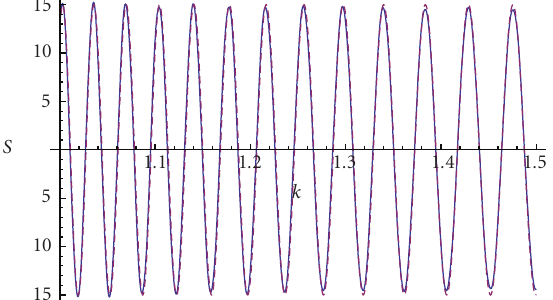
Figure 9: Numerical result (solid line) of the bispectrum running for the example (151) ( m = 3 × 10 − 6 M P , c = 5 × 10 − 7 , Λ = 0 . 0007 M P , φ ≈ 15 M P ), compared with the ansatz (148) (dashed